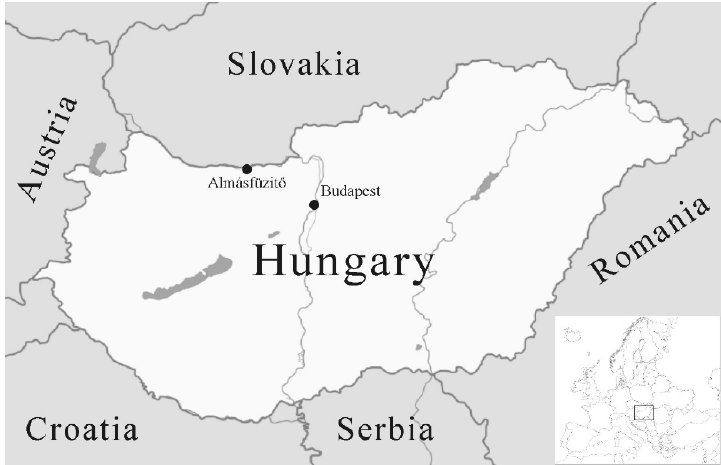
Figure 1. Position of the Almásfüzit ő red mud pitfalls in NW-Hungary.